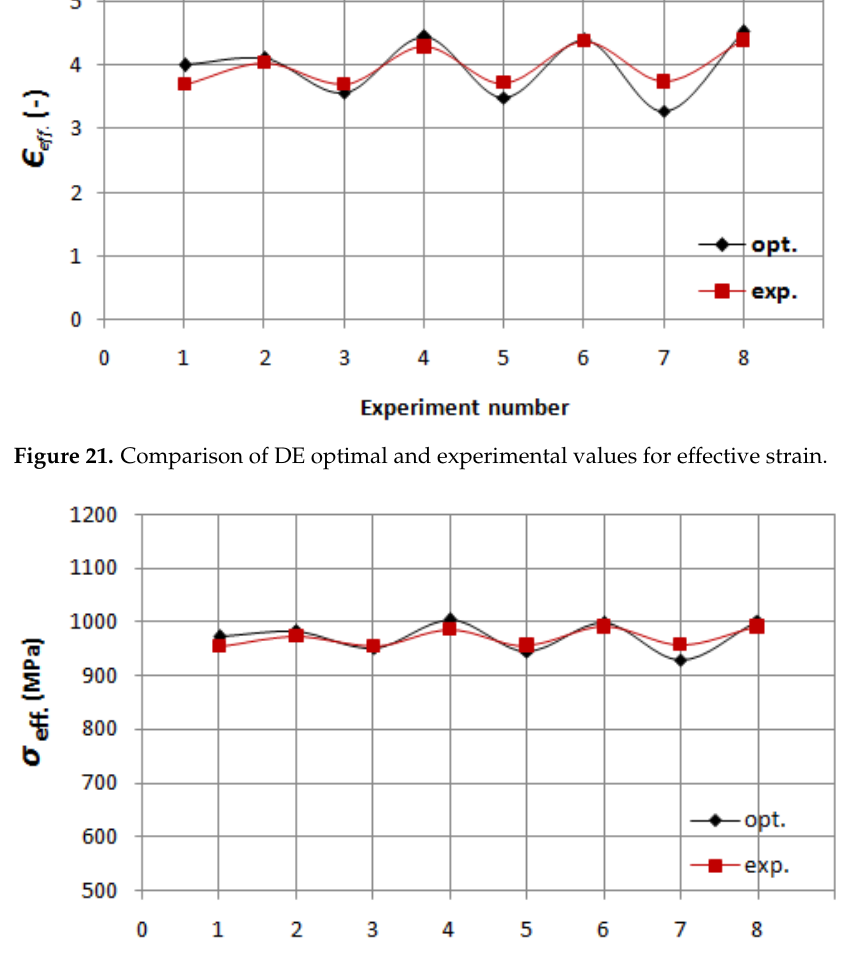
Figure 21. Comparison of DE optimal and experimental values for effective strain.